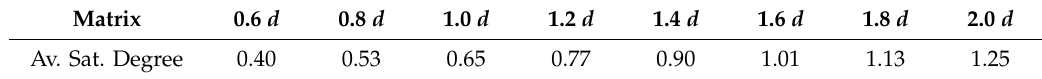
Table 8. Average saturation degrees on the rural real-scale network.